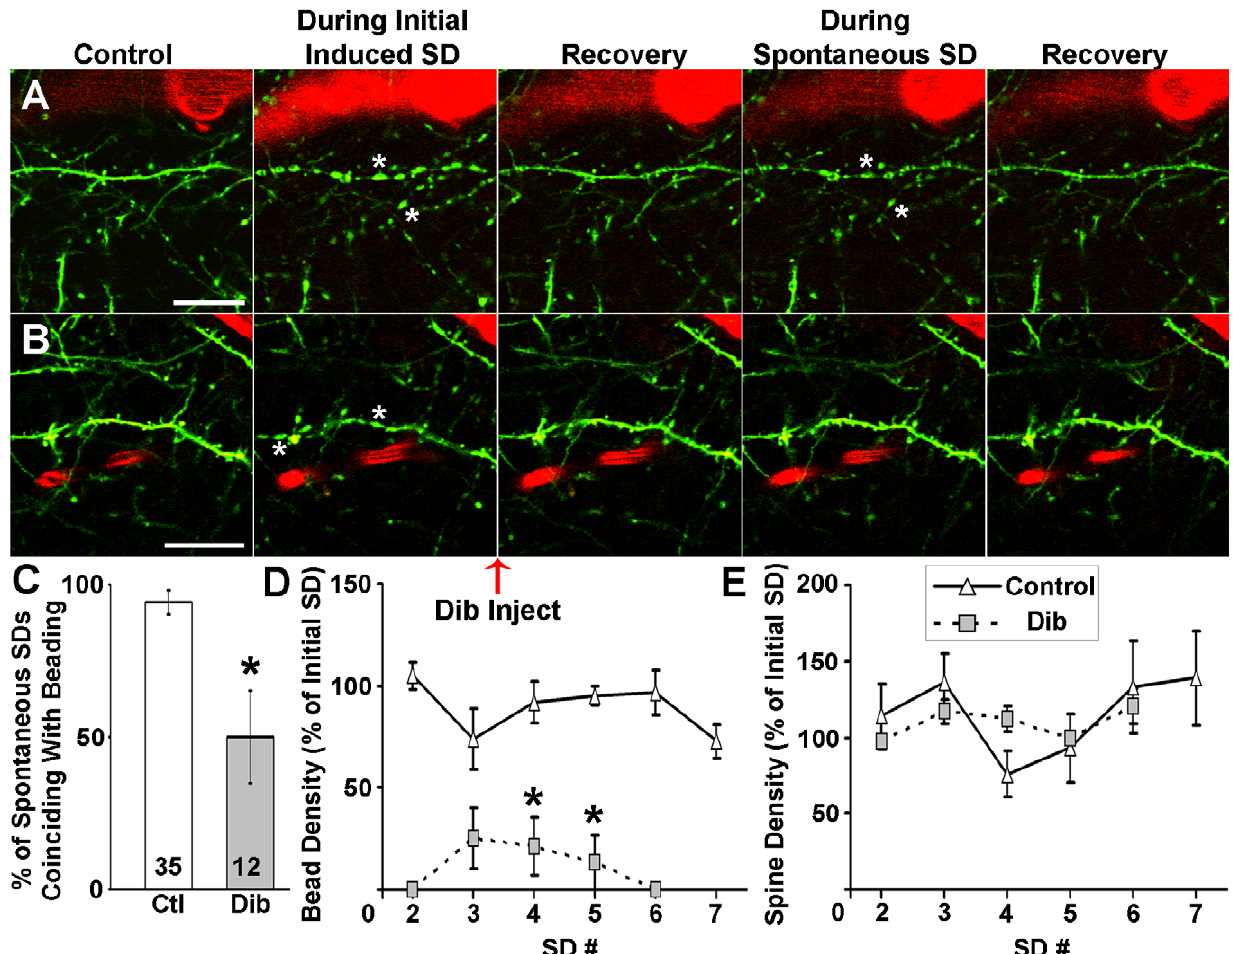
Figure 3. Dibucaine lessens dendritic beading induced by spontaneous spreading depolarizations (SDs) in penumbra. A , In vivo 2PLSM image sequence of dendrites (green) and a nearby flowing blood vessel (red; blood flow is indicated by stripes within vessel) from intact mouse somatosensory cortex. The images were taken from the center of the penumbra-like ‘‘area at risk’’, surrounded by partially occluded blood vessels [15]. The dendrites bead (asterisks) during the initial spreading depolarization induced by cortical photothrombosis. The dendrites rapidly ( , 3 min) recover but become beaded again by the next spontaneous spreading depolarization even in the presence of a flowing blood vessel before recovering once more. Scale bar, 20 m m. B , Similar sequence to that shown in A , except dibucaine (2.5 mg/kg) was injected into the tail vein immediately after the onset of induced spreading depolarization. As in A , the dendrite rapidly recovers from beading (asterisks) induced by the initial spreading depolarization, but unlike the dendrites shown in A , the dendrite in the dibucaine-treated animal does not bead during a spontaneous spreading depolarization. Scale bar, 20 m m. C , Summary showing significantly decreased occurrence of dendritic beading (* p , 0.05; Chi-Square Test) when dibucaine is administered i.v. immediately following onset of the initial spreading depolarization. D , Bead density during spontaneous spreading depolarizations is significantly decreased with dibucaine while E , spine density remains unaffected. Densities were assessed from random 30 m m segments of 3 dendrites in each imaging field as observed in maximum intensity projections of three-dimensional stacks in 5 control and 8 dibucaine treated mice. Data points (representing averages taken from individual dendrites) were only used when an image was taken near the peak of a recorded spreading depolarization. Values are shown as percentages of bead ( D ) or spine ( E ) density immediately after induced spreading depolarization (* p , 0.05; two-way RM ANOVA). between rodent and human brain have long been considered as possible reasons why neuroprotective drugs that were effective in rodent models have failed in clinical stroke trials [23]. Energy failure during stroke is universal between species, but cerebral energy metabolism, blood flow and brain size vary. The human brain is larger and gyrated, reflecting increased size and number of neurons [7]. Phylogenetic changes are also reported, as human astrocytes are bigger, more complex and diverse [38]. Spreading depolarization under normoxic conditions can be elicited in human neocortical slices by potassium application, but the threshold is higher than in rat slices [39]. Human and rodent neocortical slices are different with respect to the latency of